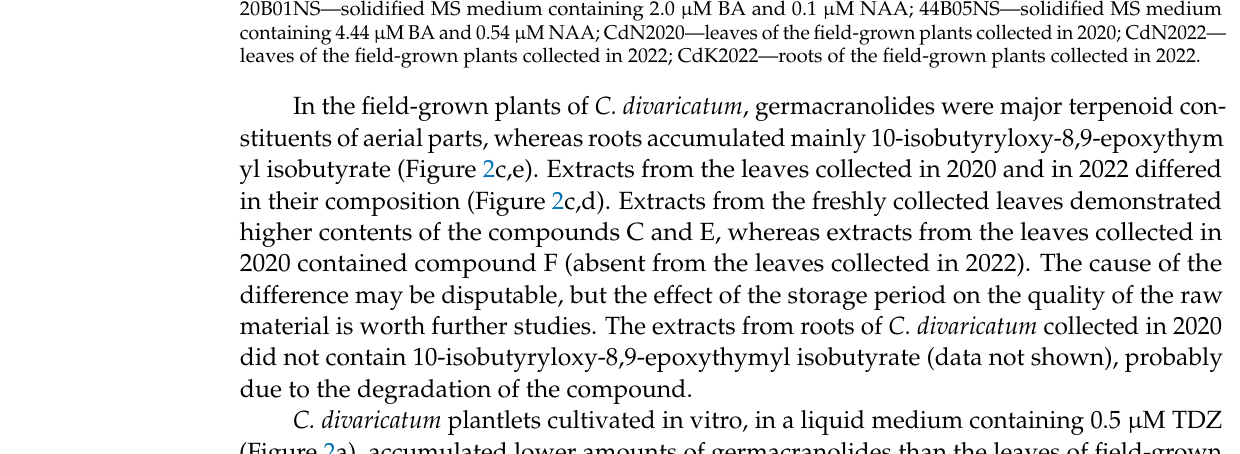
Table 2. Contents of the identified sesquiterpene lactones (A–F) and thymol derivative (G) semi- quantitatively estimated in the plant material from in vitro culture and in the organs of field-grown plants.